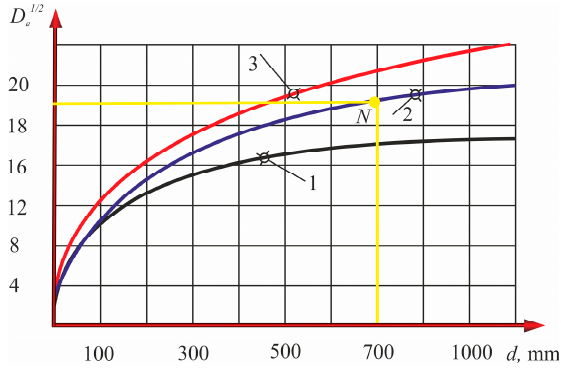
Figure 9. The effect of the diameter of the part and the diameter of the wheel on the value D e 1/2 = D · d / D + d ; 1 : D = 300 mm; 2 : D = 600 mm; 3 : n = 1000